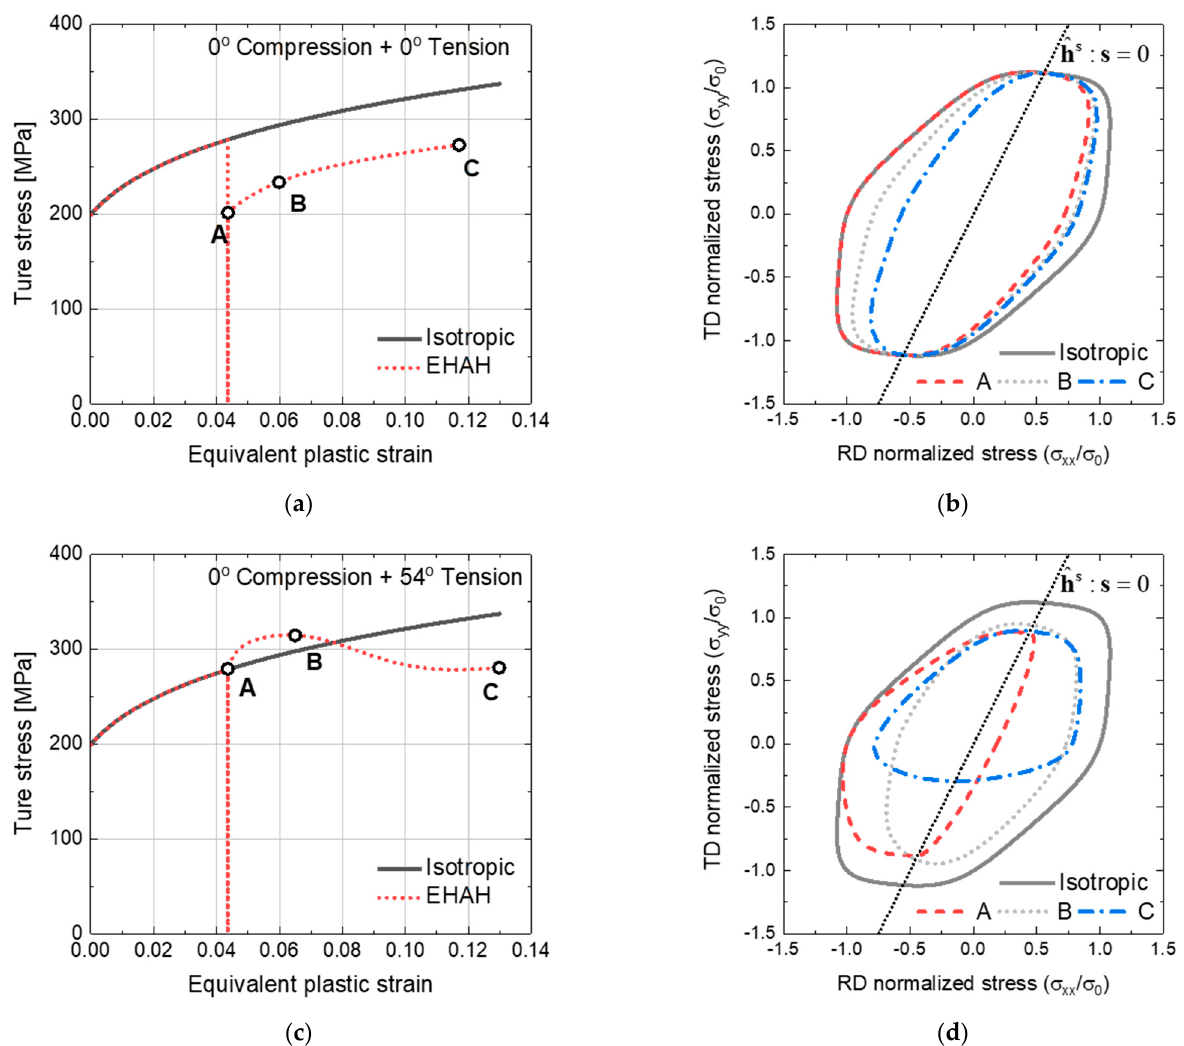
Figure 5. Stress − equivalent plastic strain curve and evolution of e − HAH yield surface for MAT 2: ( a ) flow stress curve and Figure 5. Stress-equivalent plastic strain curve and evolution of e-HAH yield surface for MAT 2: ( a ) flow stress curve and ( b ) e − HAH yield locus for C5T10R, and ( c ) flow stress curve and ( d ) e − HAH yield locus for C5T10CR. ( b ) e-HAH yield locus for C5T10R, and ( c ) flow stress curve and ( d ) e-HAH yield locus for